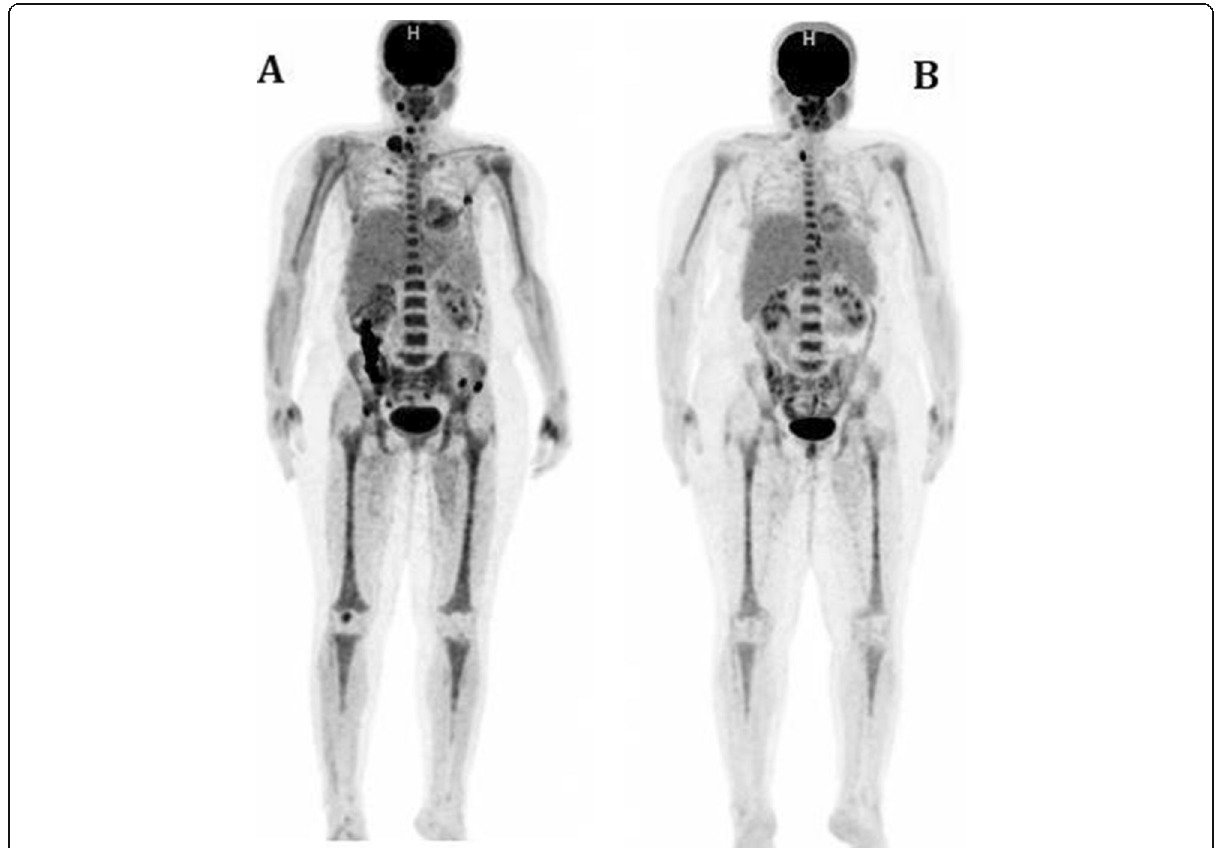
Fig. 8 Pre- and postoperative maximum intensity projection images of 18 F-FDG PET/CT: FDG-avid multiple skeletal lesions in the preoperative FDG PET/CT scan maximum intensity projection image ( A ) that shows complete metabolic resolution in the postoperative 18 F-FDG PET/CT MIP image ( B )